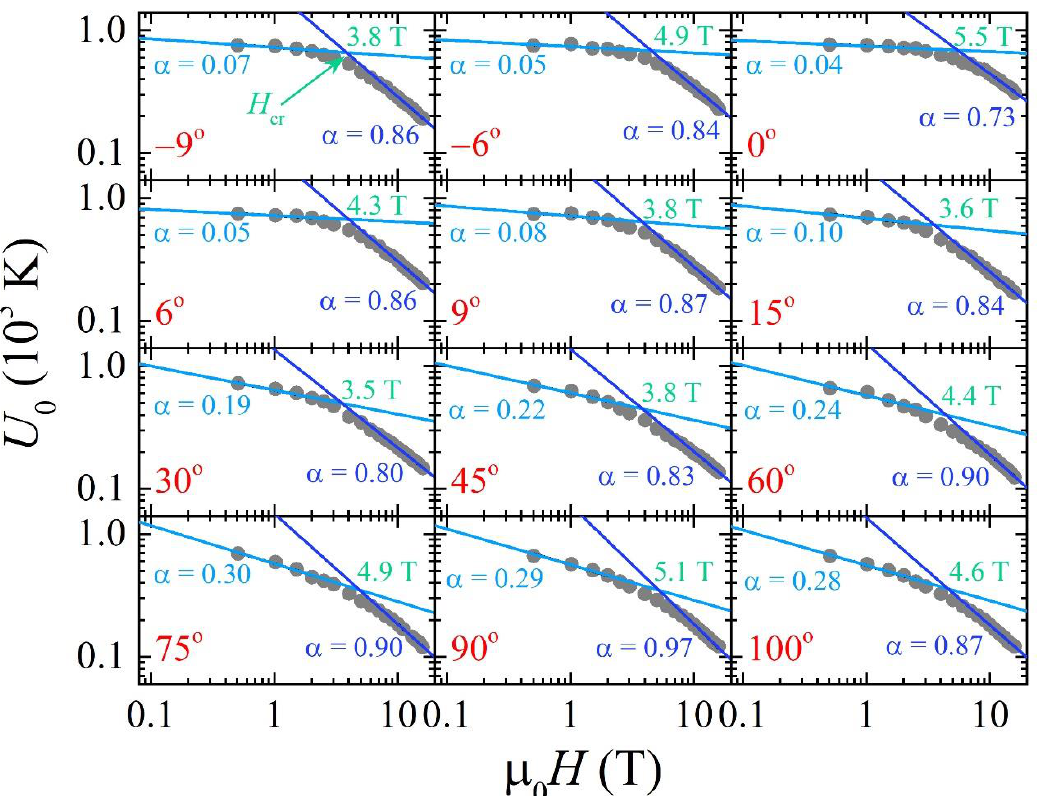
Figure 4. Flux pinning energy as a function of the applied magnetic field in the different field configurations.